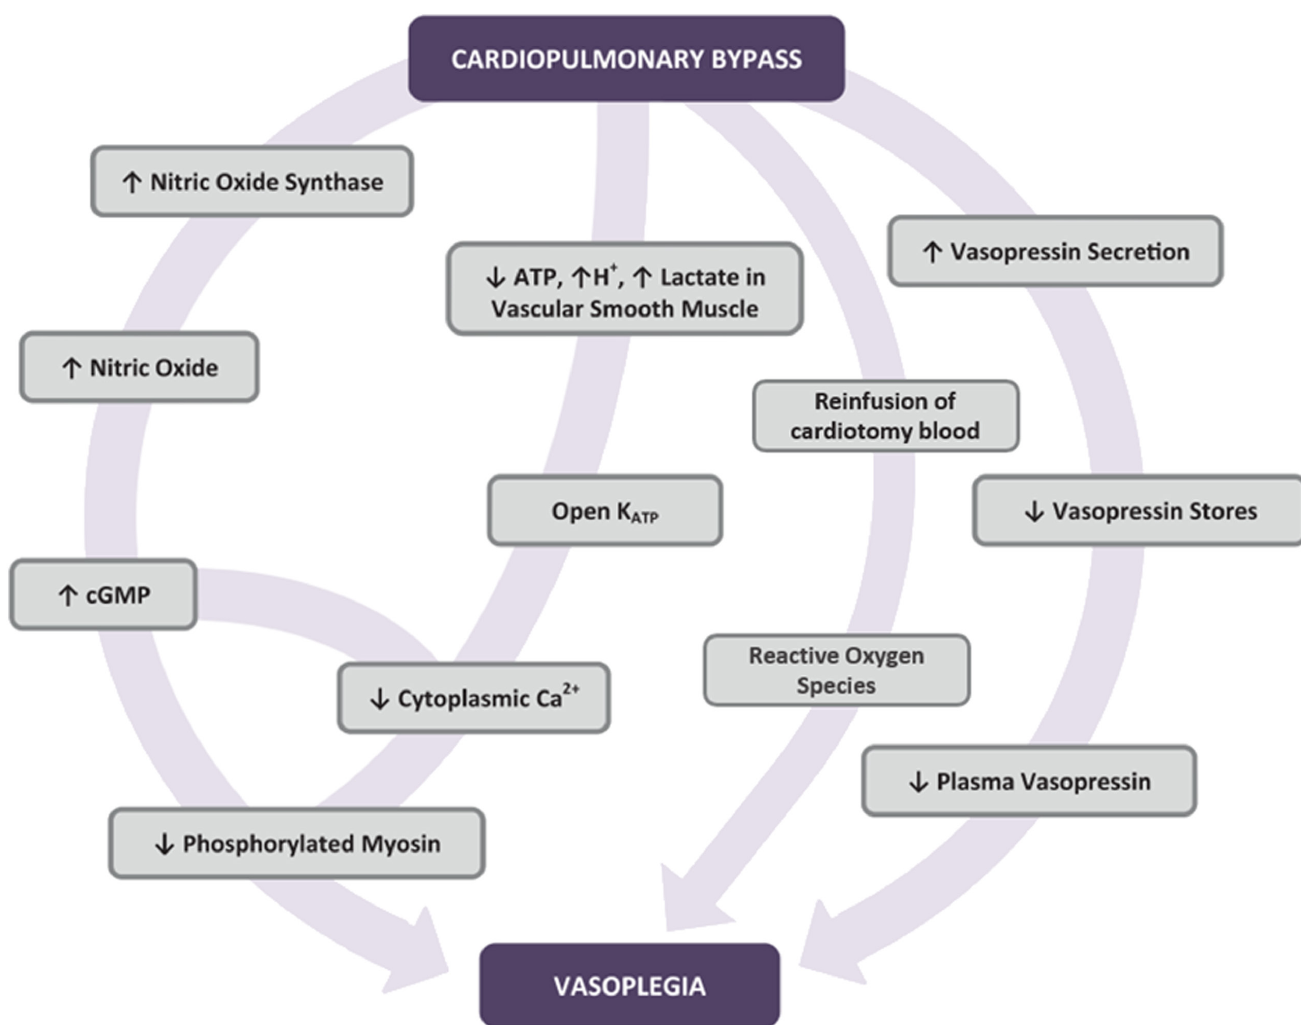
Figure 2. The mechanism of CPB-associated vasoplegia. Cardiopulmonary bypass triggers a severe inflammatory reaction that increases NO production, ATP depletion, and an increase in the vascular smooth muscle acidemia, which results in decreased myosin phosphorylation and vasodilation. Simultaneously, neuro- hypophyseal deposits from endogenous vasopressin are depleted rapidly, adding to the vasodilation effect and creating vasoplegia. ATP: adenosine triphosphate, cGMP: cyclic guanosine monophosphate, CPB: cardiopulmonary bypass; KATP: ATP-sensitive potassium channel.